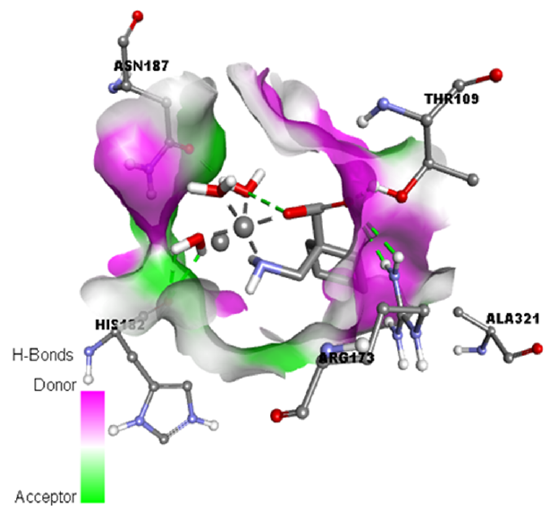
Figure 9. Representation of the hydrogen binding surface between the serotonin and metal complex [Cu(II)–(Gpn)].